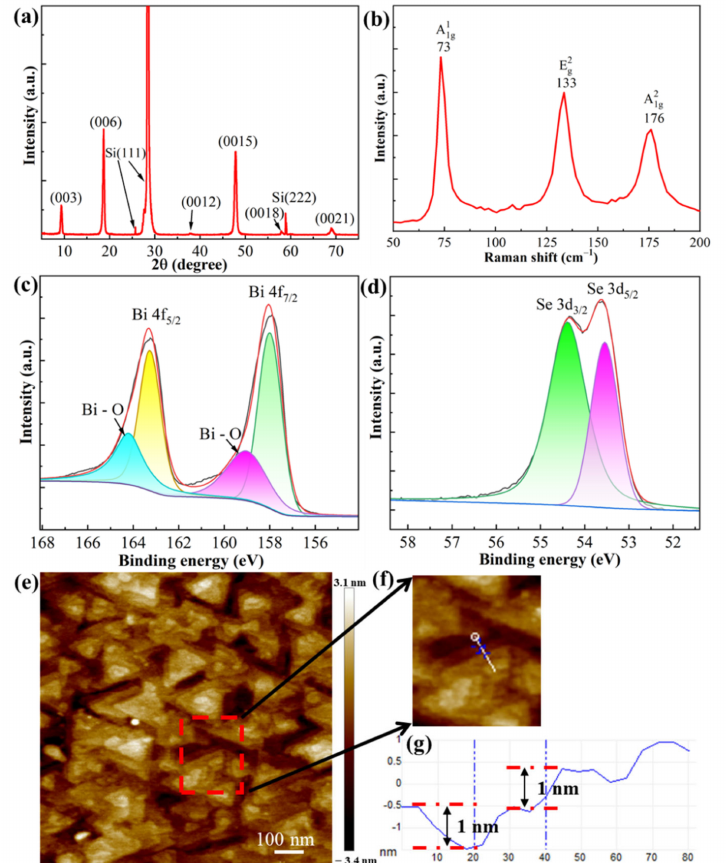
Figure 2. Bi 2 Se 3 film grown at the optimal condition: Bi cell temperature of 750 ◦ C, Se cell temperature of 204 ◦ C and growth temperature of 320 ◦ C. ( a ) XRD; ( b ) Raman; ( c , d ) XPS of Bi 4f and Se 3d with the fitting curves; ( e ) AFM of Bi 2 Se 3 film surface and ( f ) local enlargement; ( g ) atomic step